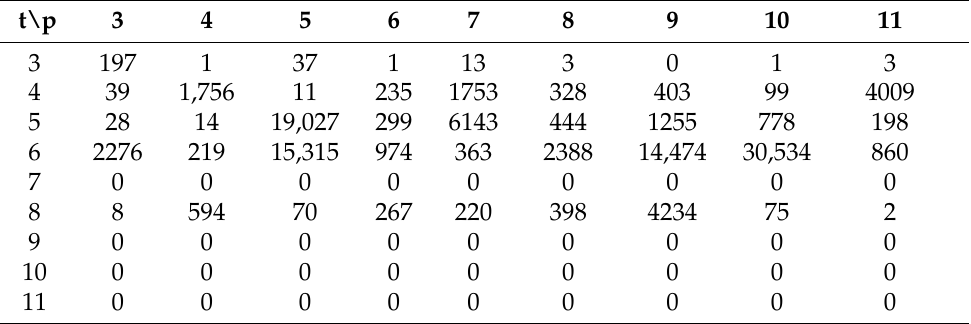
Table 14. The confusion matrix for SPPB of participant 19. This participant was the only one with a SPPB score of 2. Since the model was not trained to classify this score, the values for score 2 were not considered for classification. t = true label, p = predicted